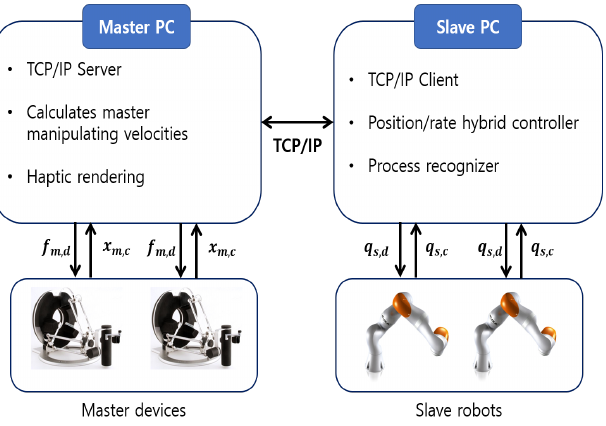
Figure 4. Teleoperation system with the process-recognizer-based hybrid controller.